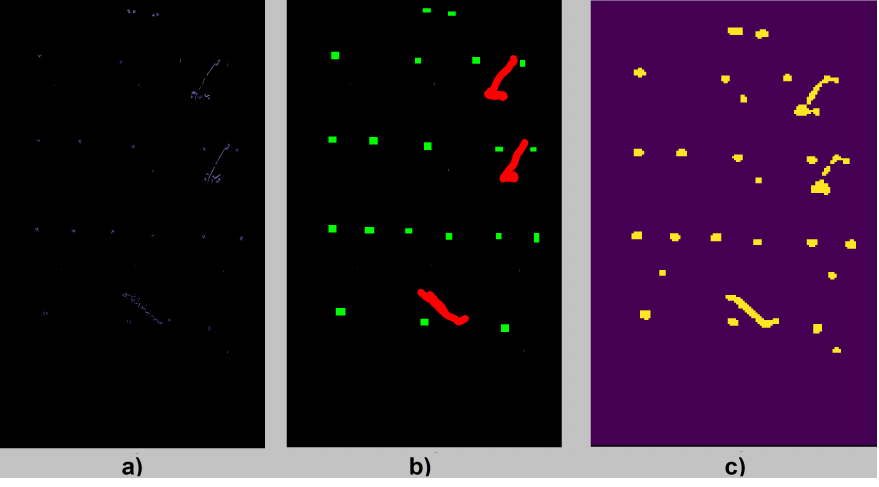
Figure 5. In part ( a ), the masked figure is shown. In part ( b ), the 3-class annotated image and in part ( c ), the prediction of our model (updates and numerals vs. background) are